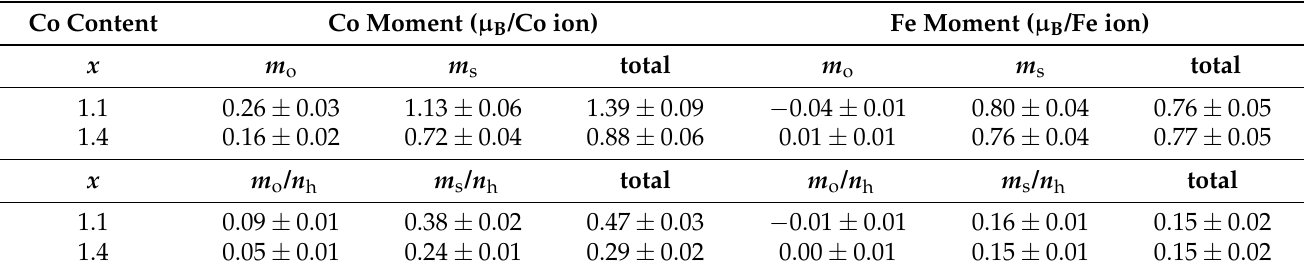
Table 1. Orbital moment m o , spin moment m s , and total moment for the Co and Fe ions for the Co x Fe 3 − x O 4 films with Co contents of x = 1.1 and x = 1.4 determined from the Co XMCD and Fe XMCD spectra using the sum rules [41–44] and the sum rules’ correction factors as derived by Teramura et al. [45]. For comparison, the respective magnetic moments normalized to the number of holes ( n h = 3 for the Co ions and n h = 5 for the Fe ions) are displayed underneath.